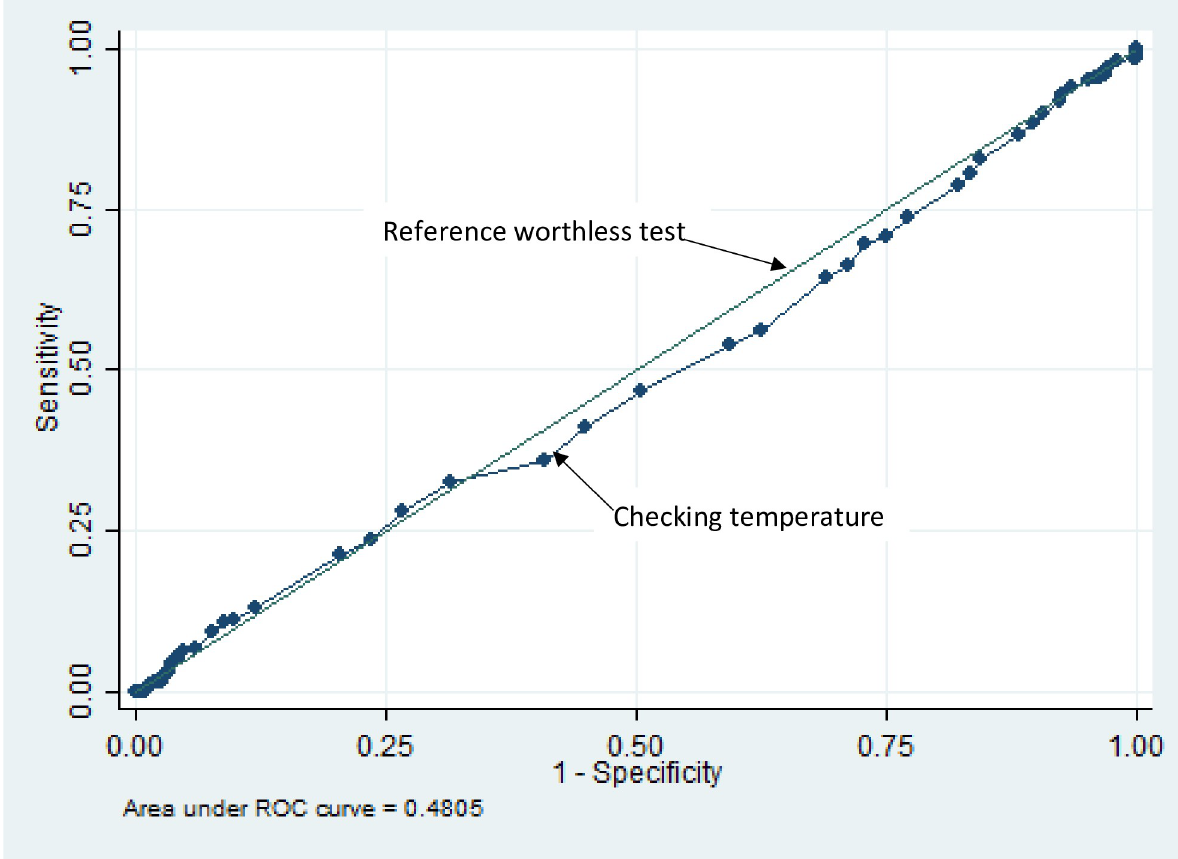
Fig 4. Receiver operator characteristic curve for checked temperature as a screening tool for SARS-CoV-2 infection.